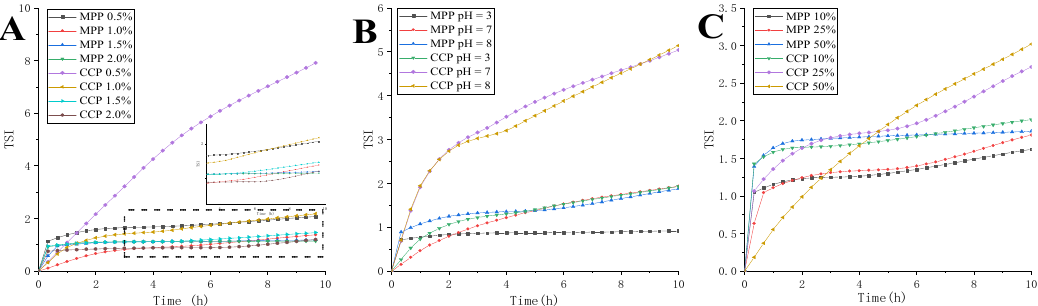
Figure 3. The effect of different pectin concentration ( A ), pH ( B ) and oil ratio ( C ) on the TSI (Turbiscan index) of the emulsions.